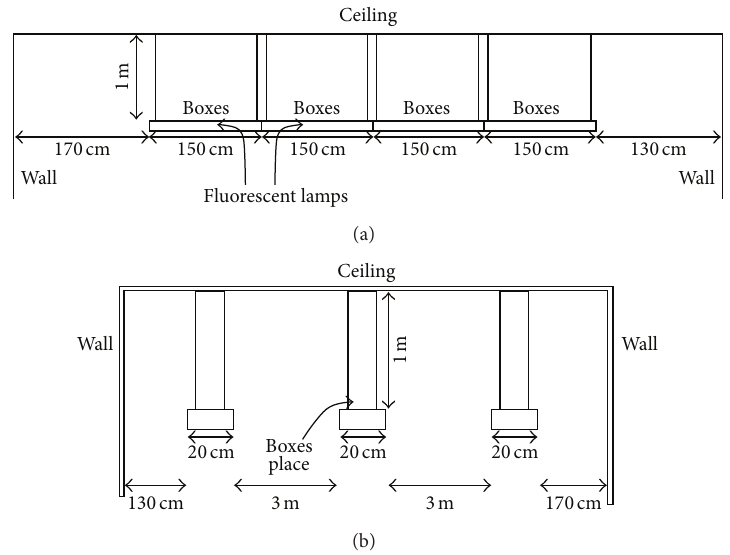
Figure 4: Schematic rear and side view of fluorescent lamps in conference